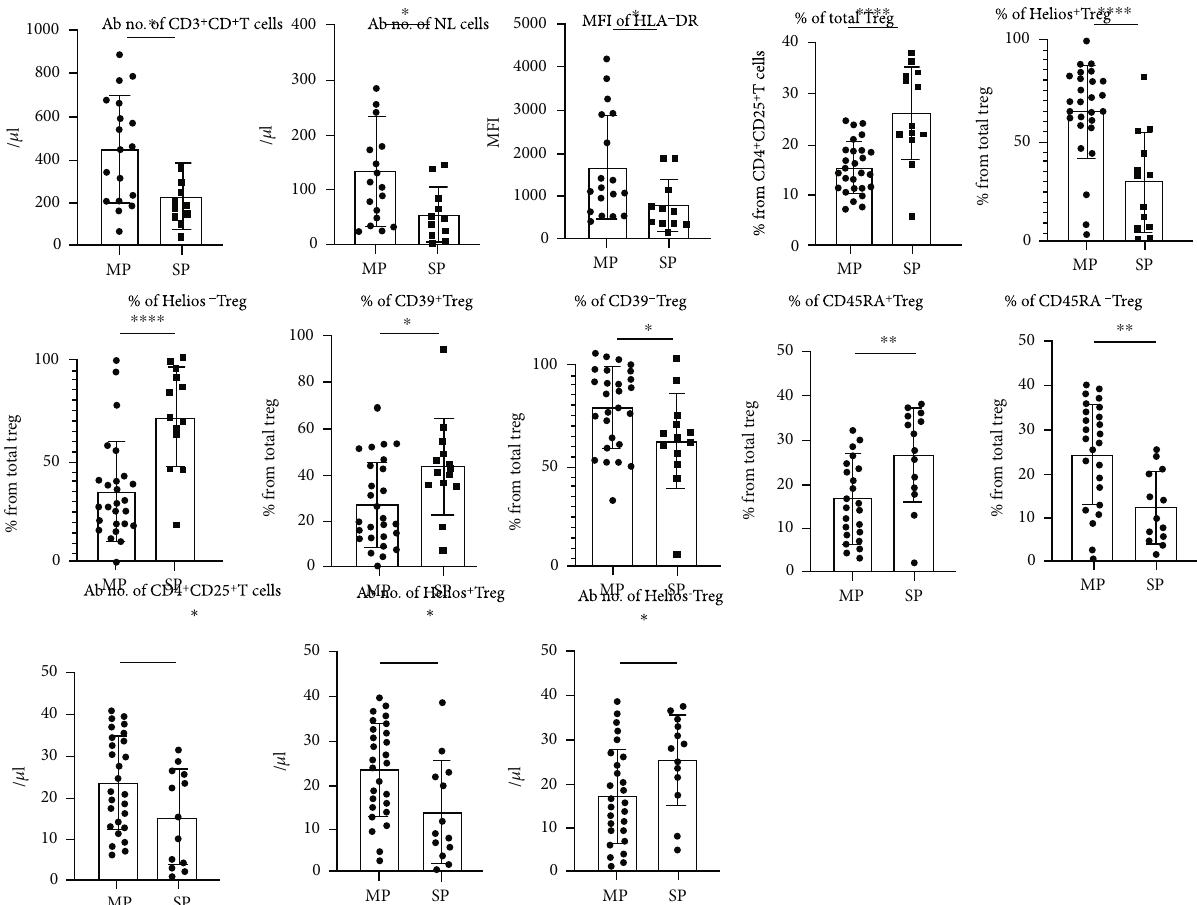
Figure 3: The distribution, Ab No., and MFI of regular immune indexes and Treg subpopulations in MP and SP patients. ∗∗∗∗ means